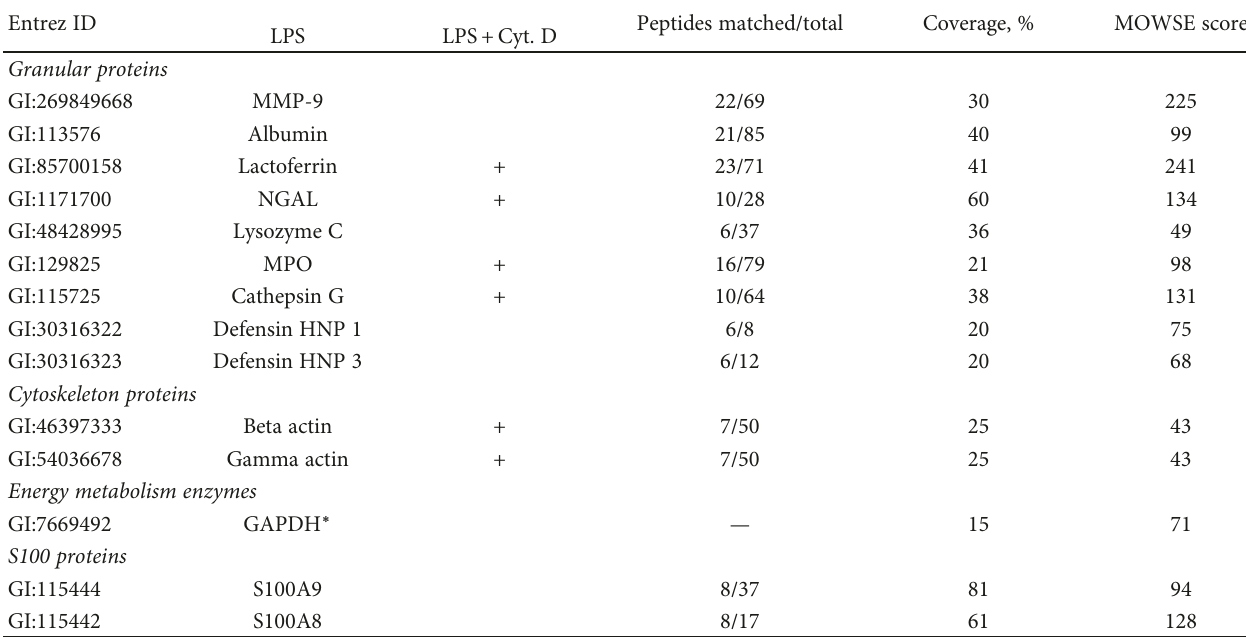
Table 3: A list of proteins that were secreted by neutrophils into the extracellular medium during a 20 min incubation with fi bronectin-coated substrata in the presence of 20 μ g/mL LPS alone, 10 μ M cytochalasin D (Cyt. D) alone, or in the presence of both 20 μ g/mL LPS and 10 μ M cytochalasin D (LPS +Cyt. D). Mass spectrometric analysis data were taken from experiments with LPS. Analogous proteins that were identi fi ed in experiments with LPS+Cyt. D are marked (+). Proteins were separated by SDS-PAGE and identi fi ed by mass spectrometric analysis. ∗ Protein was identi fi ed by MSMS analysis. Proteins identi fi ed in two or three analogous experiments were included in the list.